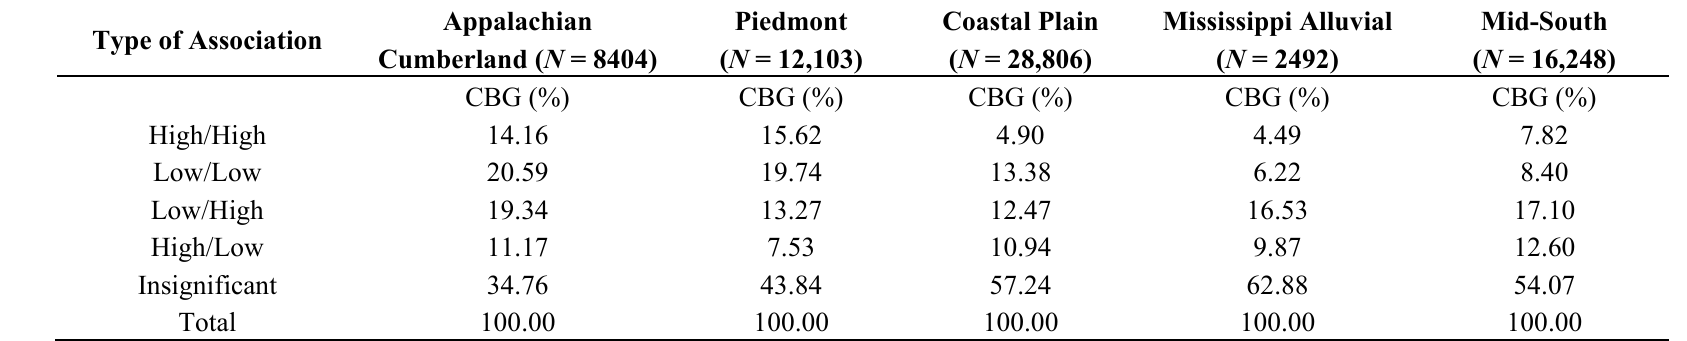
Table 5. Distribution of LISA Clusters by